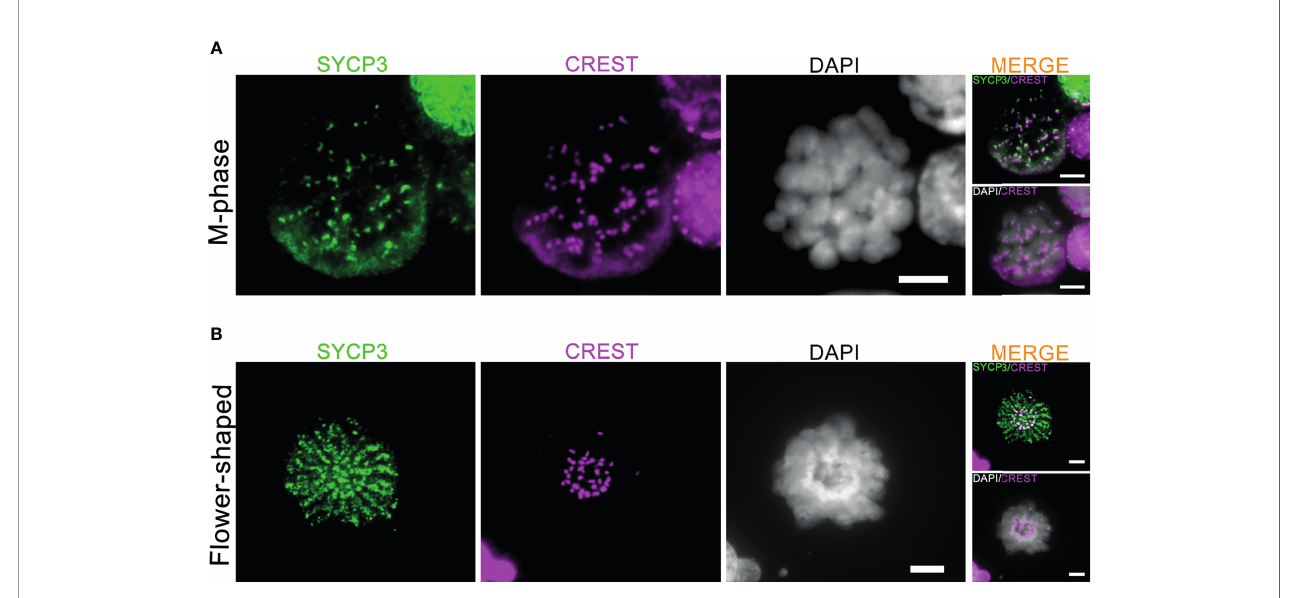
FIGURE 4 | Generation of meiotic M-phase cells and fl ower-shaped in vitro . The co-immuno fl uorescent staining of SYCP3 (red), centromeres (CREST, pink) and DNA (DAPI, white) for in vitro -generated meiotic M-phase cells (A) and “ fl ower-shaped ” cells (B) . Scale bars, 5 m